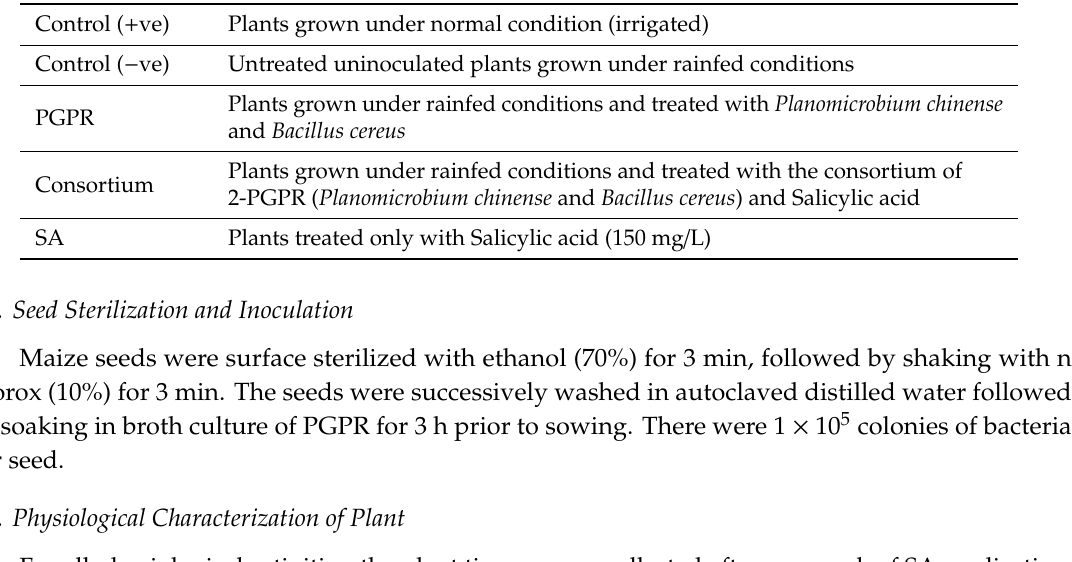
Table 1. Treatments